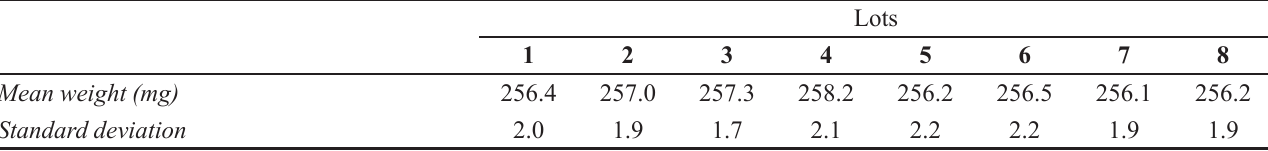
TABLE VI - Mean weight and standard deviation for lots 1-8 of coated tablet cores